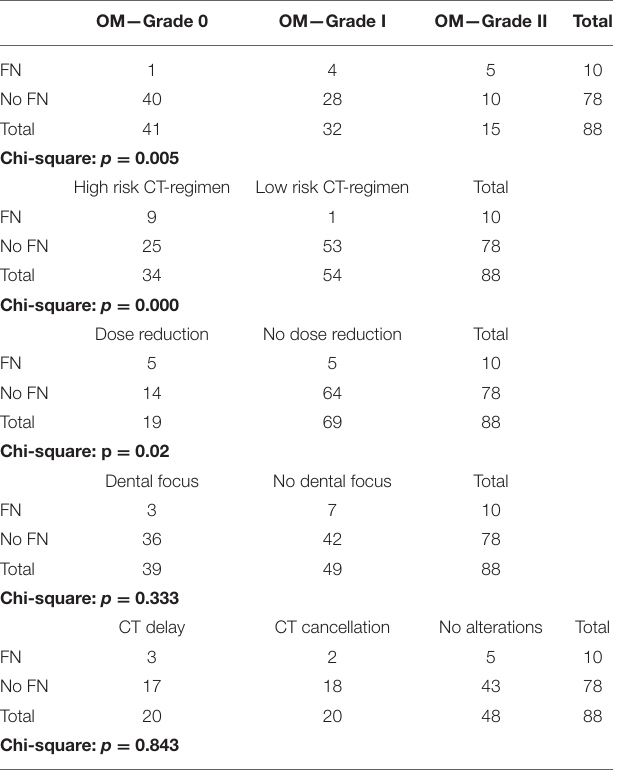
TABLE 5 | Dental foci, oral mucositis, febrile neutropenia and unplanned CT modifications ( N =